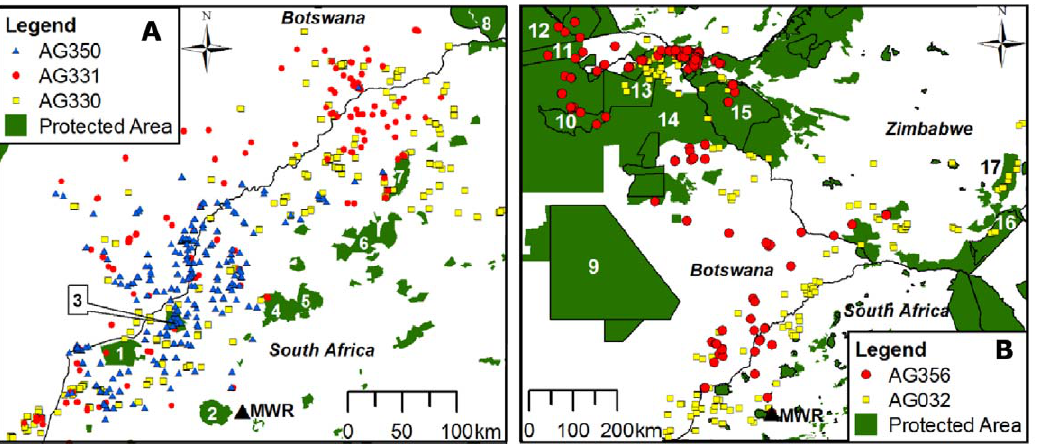
Figure 4. Stationary GPS locations of immature African white-backed vultures in relation to protected areas. (A) shows stationary GPS locations from AG330, AG331 and AG350 in relation to protected areas in the North West and Limpopo Provinces of South Africa: 1= Madikwe GR; 2= Pilanesberg NP; 3= Atherstone NR; 4= Marakele NP; 5= Welgevonden NR; 6= Lapalala, Moepel et al. reserves; 7= Wonderkop NR; 8= Tuli conservation area. (B) shows stationary GPS locations from AG356 and AG032 in relation to protected areas across southern Africa: 9= Central Kalahari NP; 10= Moremi GR; 11= Caprivi GR; 12= Luiana NP (Angola); 13= Chobe NP; 14= Wildlife Management Areas; 15= Hwange NP; 16= Gonarezhou NP; 17= Save Conservancy. Protected area data are from WDPA